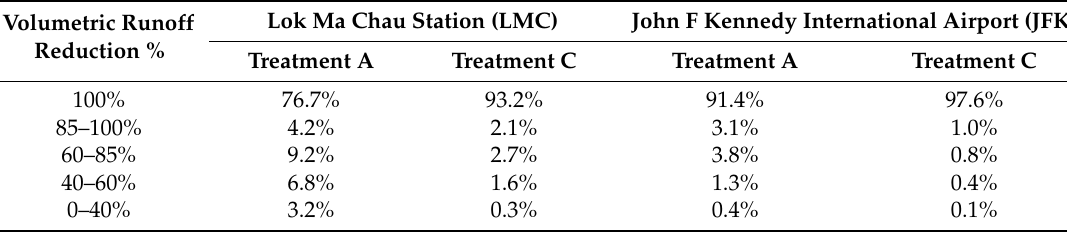
Table 6. Percentage of rainfall events at each level of volumetric runoff reduction.